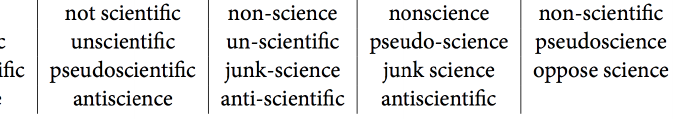
Figure 1. Dataset search keywords. Keyword phrases used fuzzy matching to additionally capture close but not identical phrase matches, such as ‘‘not really science.’’